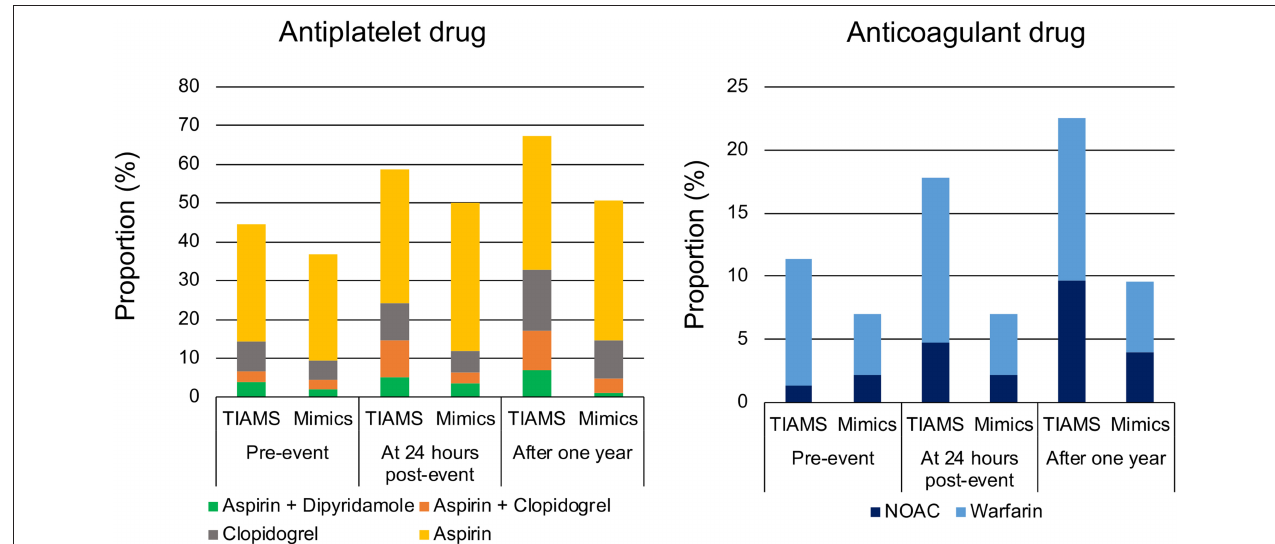
FIGURE 3 | Antiplatelet and anticoagulant drugs pre-index event, at 24h post-index event and after 1 year in TIAMS- and TIAMS-mimic-group participants (these are simple proportions). TIAMS, transient ischemic attack and minor stroke; NOAC, non-vitamin K antagonist oral anticoagulant.